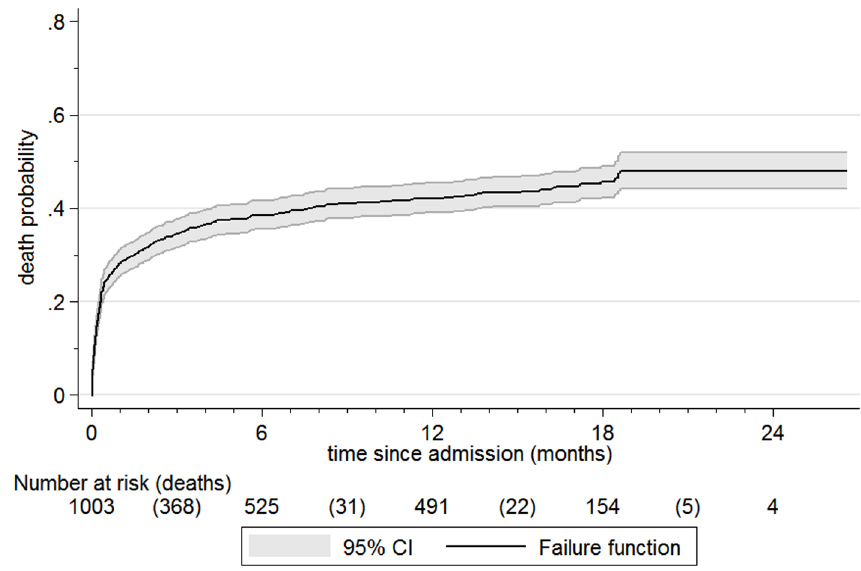
Figure 2. Kaplan Meier failure curve, all patients.